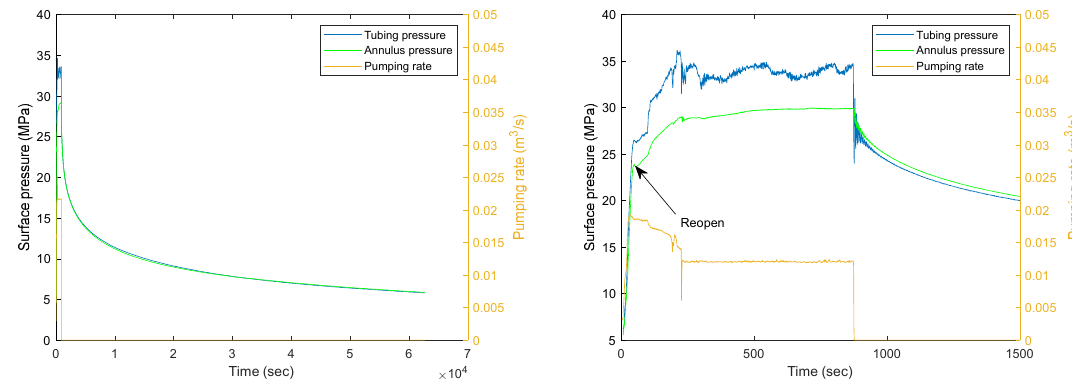
Figure 11. Surface pressure and pumping rate for Zone 2 Cycle 8. Left is the entire injection and shut- in pressure, while the view at right is a zoomed-in view of early time shut-in data. The apparent reopening pressure is picked from the surface annulus pressure as 23.7 MPa (bottomhole pressure 44.5 MPa). The friction pressure obtained from the step-down rate test for Zone 2 Cycle 7 is 2.8 MPa at a pumping rate of 2.1 × 10 − 2 m3 / s. After correcting for friction, the reopening pressure is 41.7 MPa, and the closure stress gradient is 19.7 MPa / km.